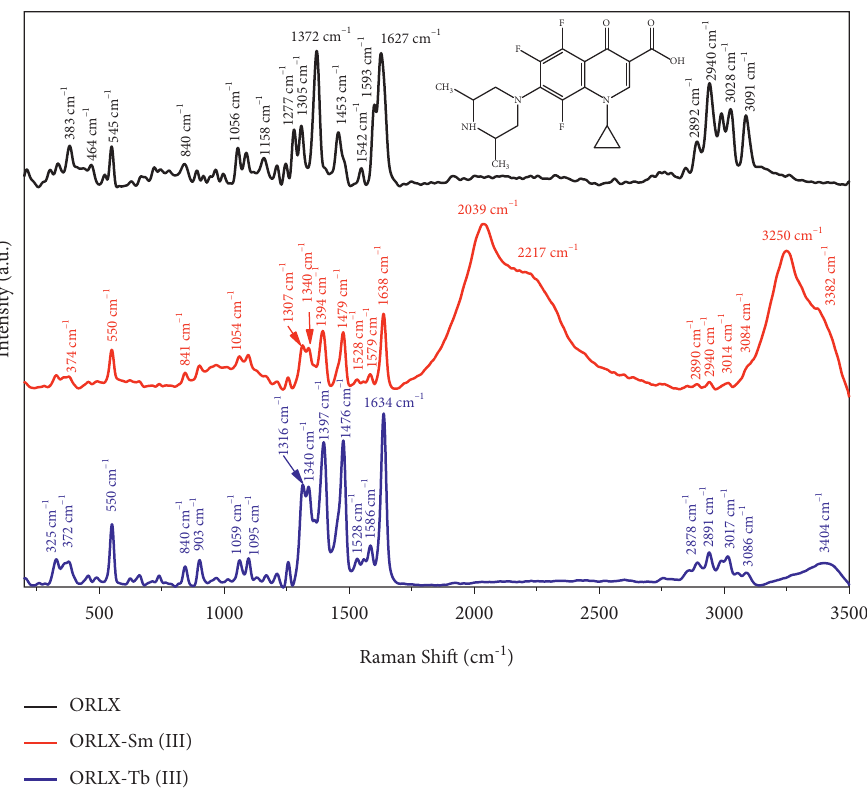
Figure 6: Raman spectra of ORLX, ORLX-Sm(III), and ORLX-Tb(III) complexes. Table 5: CHN elemental analysis of ORLX, ORLX-Sm(III), and ORLX-Tb(III)